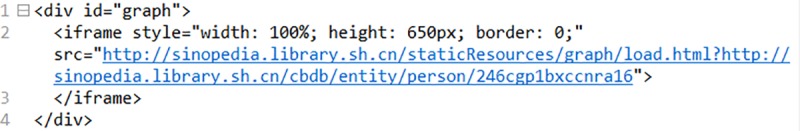
Code for LDKS service in a program.